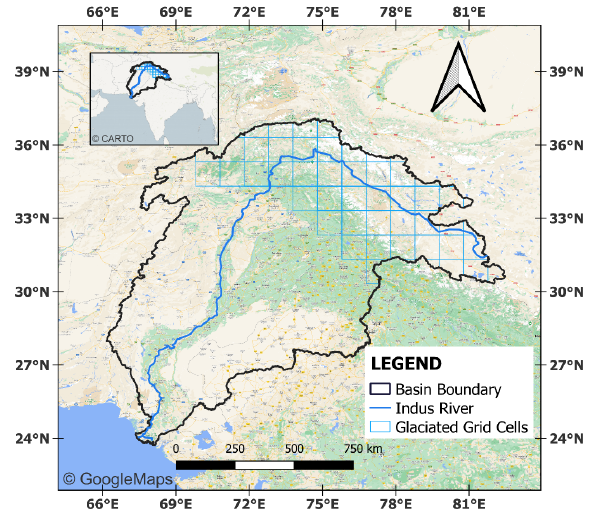
Figure 1. The Indus Basin. The blue squares represent the glaciated areas as cells of 1 ◦ size. Basin boundaries by the International Cen- tre for Integrated Mountain Development (ICIMOD). Main back- ground map ©Google Maps and inset map